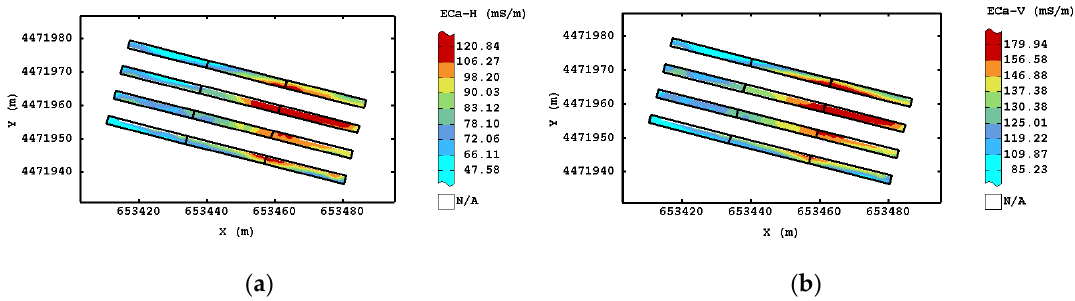
Figure 4. Spatial estimate of apparent electrical conductivity (ECa) in ( a ) horizontal and ( b ) vertical polarization. Color scale uses iso-frequency classes.